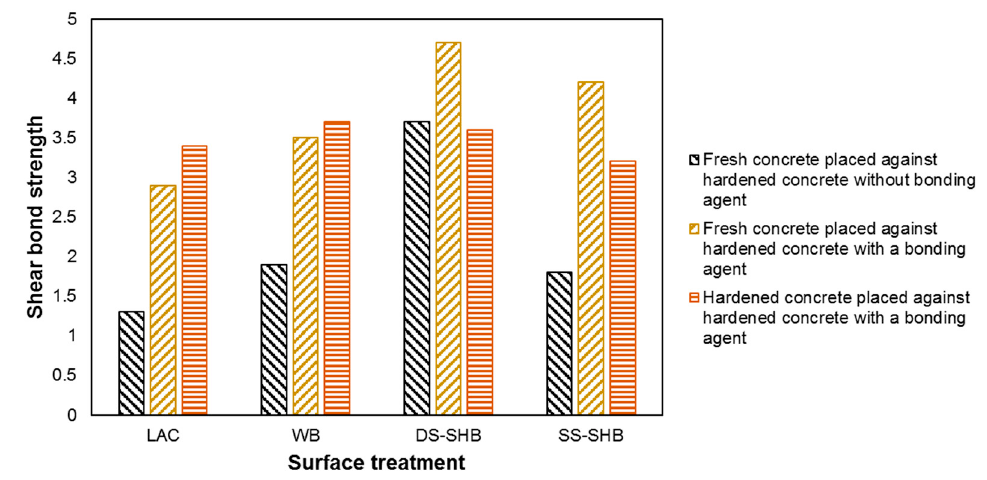
Figure 15. The relation of shear bond strength with regards to the used bonding agent and the method of surface treatment: LAC—the left as cast surface, WB—the wire-brushed surface, DS-SHB—the dry shot-blasted substrate, SS-SHB—the saturated shot-blasted substrate (based on the results presented in Reference [58]).